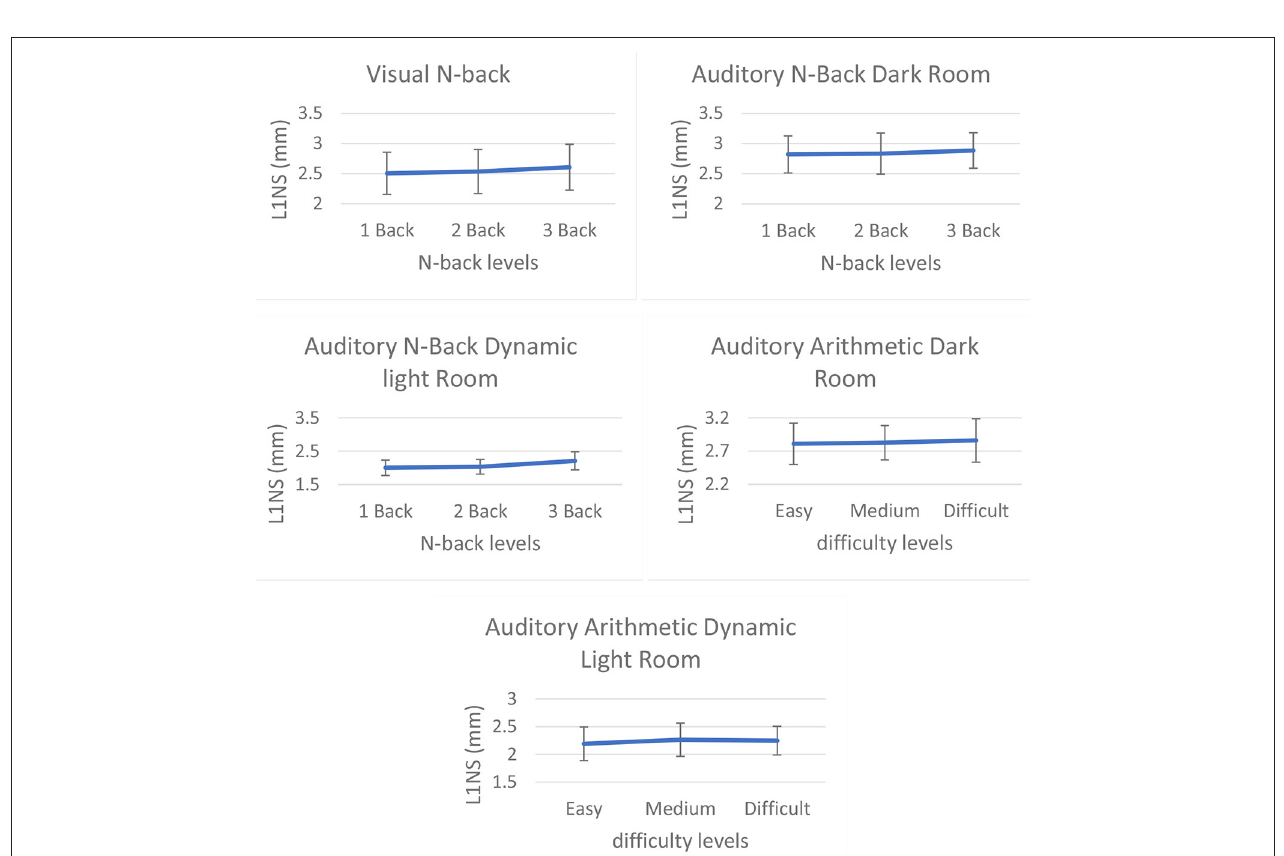
FIGURE 2 | L1NS of the right eye for (from top left) visual N-back, auditory N-Back dark room, auditory N-back dynamic lightroom, auditory arithmetic dark room, and auditory arithmetic dynamic lightroom.